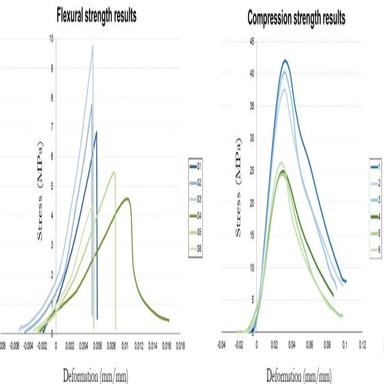
Comparison between the results of the three-point flexural test (left) and compression test on the broken specimen (right).